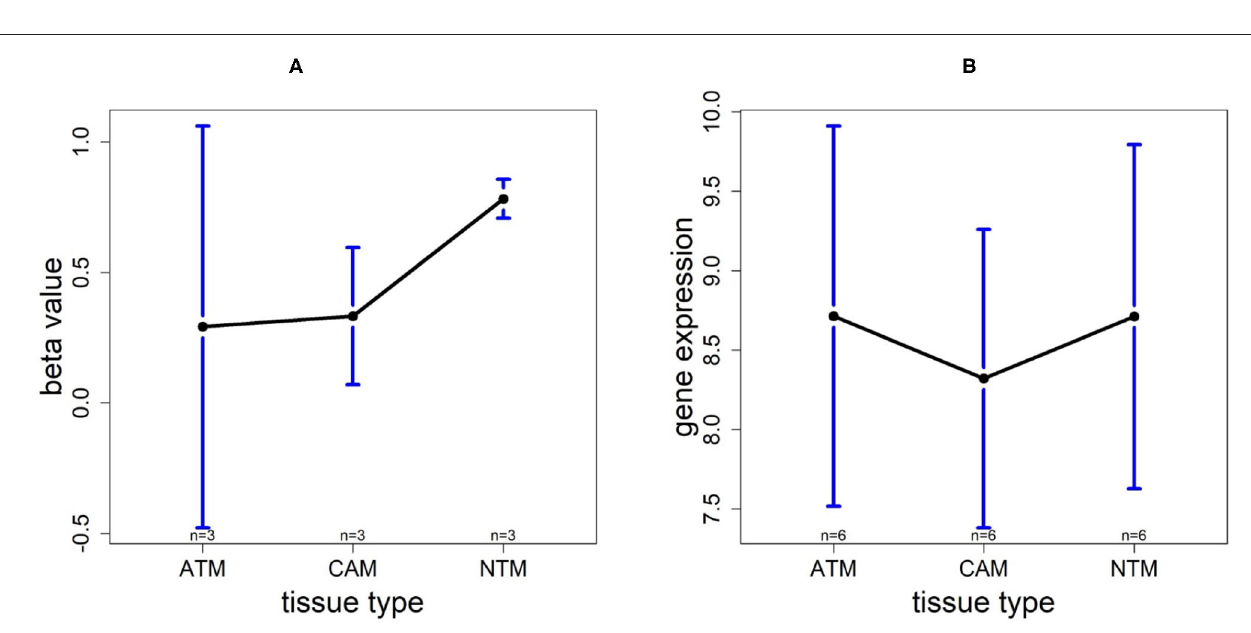
FIGURE 11 | The overall methylation and gene expression levels of the TMTC1 promoter region. (A) Averaged methylation level over the three samples of gene TMTC1 among tissue types from GSE97686 dataset. (B) Averaged gene expression level over the three samples of gene TMTC1 among tissue types from GSE107161 dataset. The blue bars represent 95% confidence intervals. Some error bars are large as the sample size is only 3 in each tissue